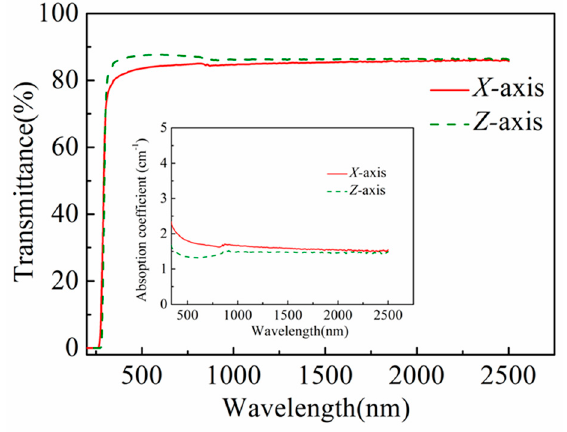
Figure 2. The transmission spectra of Ba 2 TiSi 2 O 8 at room temperature.